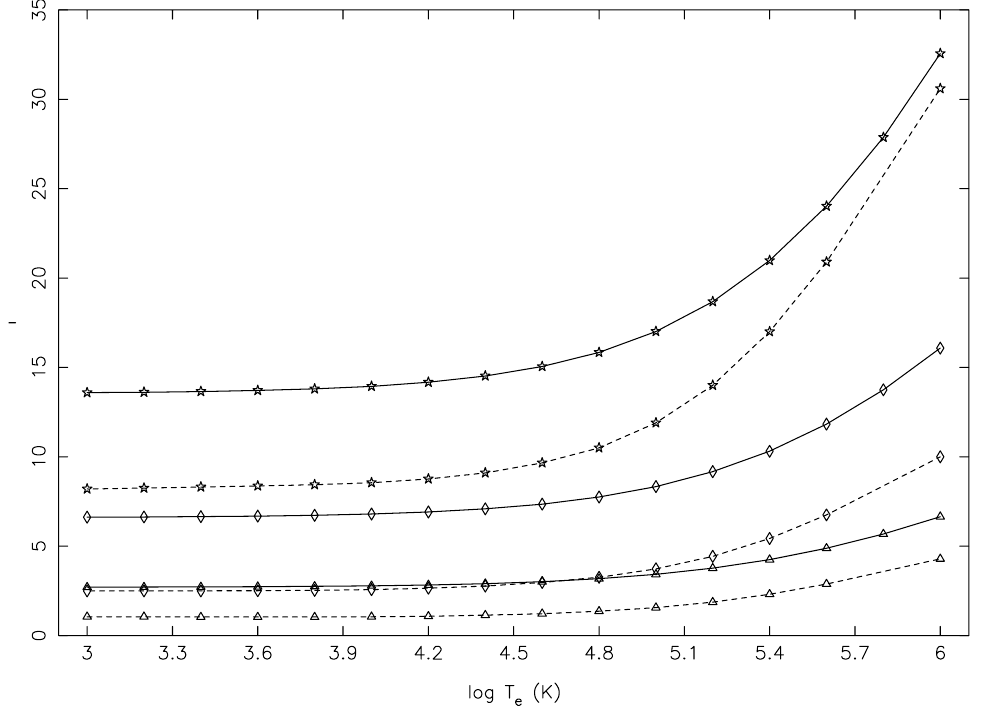
Figure 3. Comparison of FAC and B-spline R -matrix (BSR) values of Υ for the 1–25 (triangles: 3p 2 3 P 0 –3p3d 3 D o ), 2–26 (diamonds: 3p 2 3 P 1 –3p3d 3 D o 1 of S III. Continuous curves present the results with FAC; broken curves are the earlier results of Tayal et al. [1] with